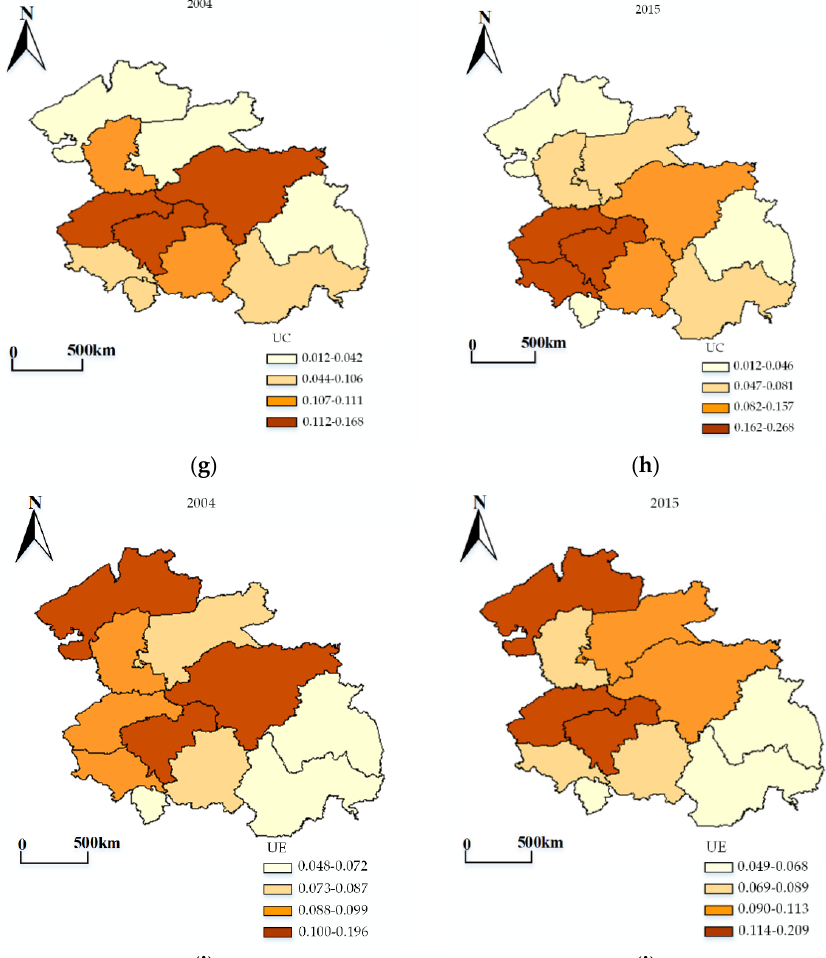
Figure 9. The temporal evolution and spatial differentiation of the LCCC in the HCUA. ( a , b ) are spatial and temporal differentiation maps of LCCC in 2004 and 2015. ( c – j ) are each subsystem’s spatial and temporal differentiation maps of LCCC in 2004 and 2015.